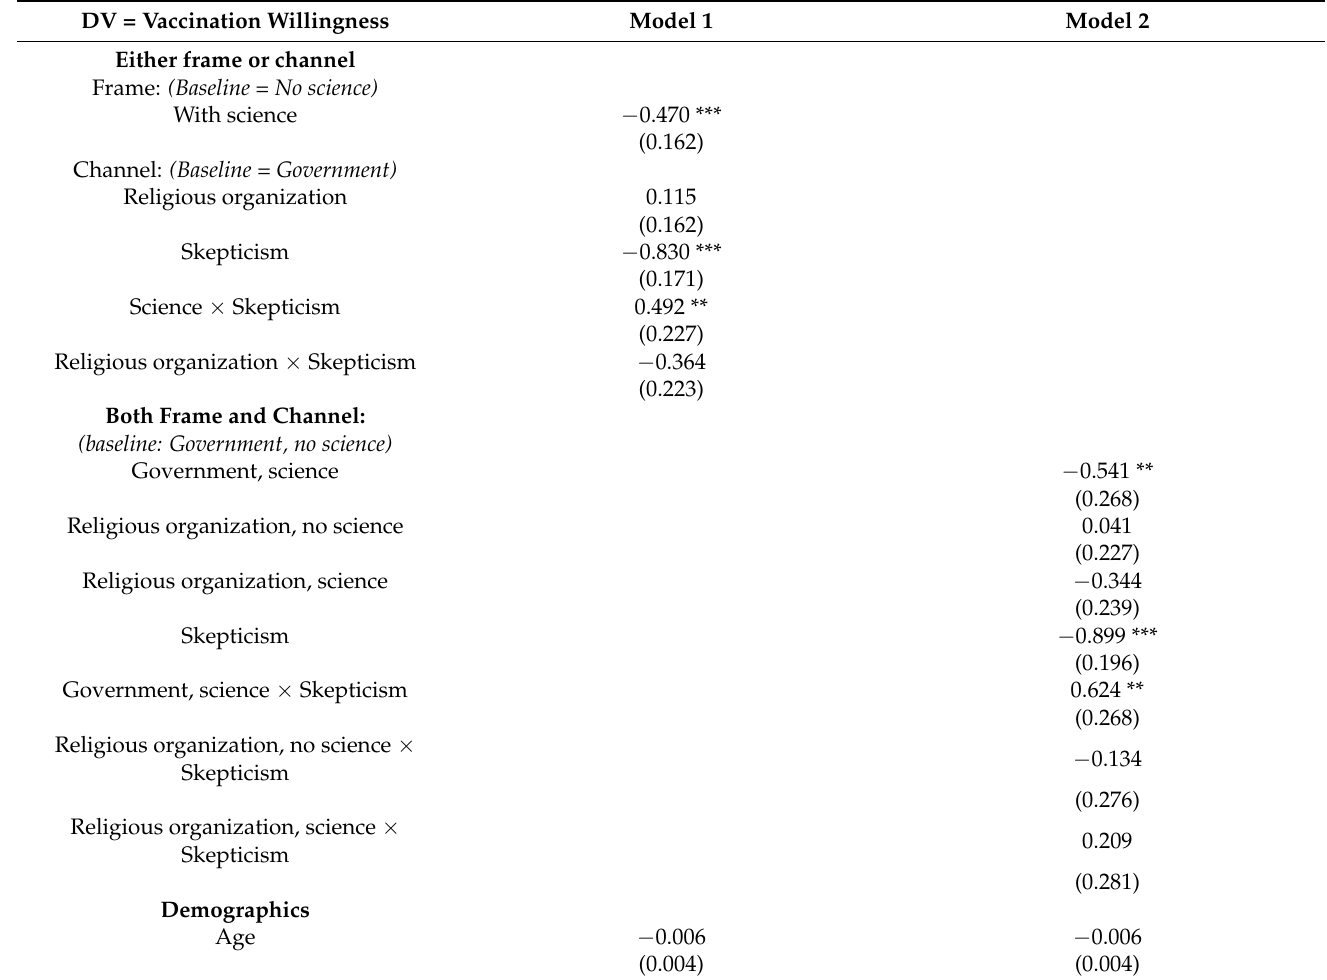
Table 3. Vaccine information frame, channel, and vaccination